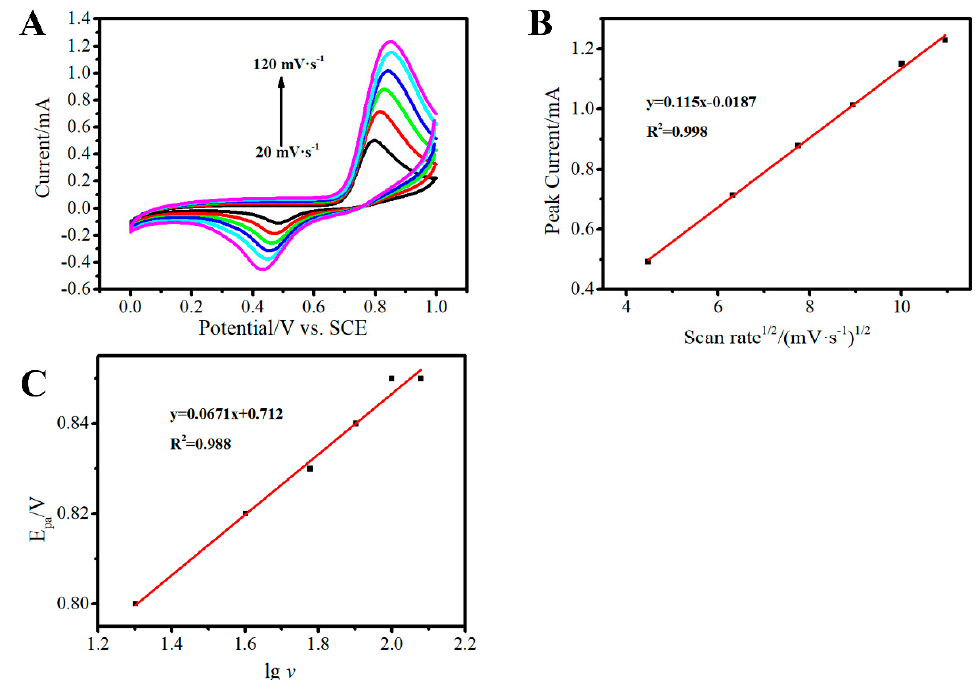
Figure 8. CVs of the 3D Au-rGO/FTO in PBS containing 1.5 mM nitrite at scan rates from 20 to 120 mV s − 1 ( A ), the plots of anodic peak currents to the square root of scanning rates ( B ), anodic peak potentials versus lg𝑣 ( C ).